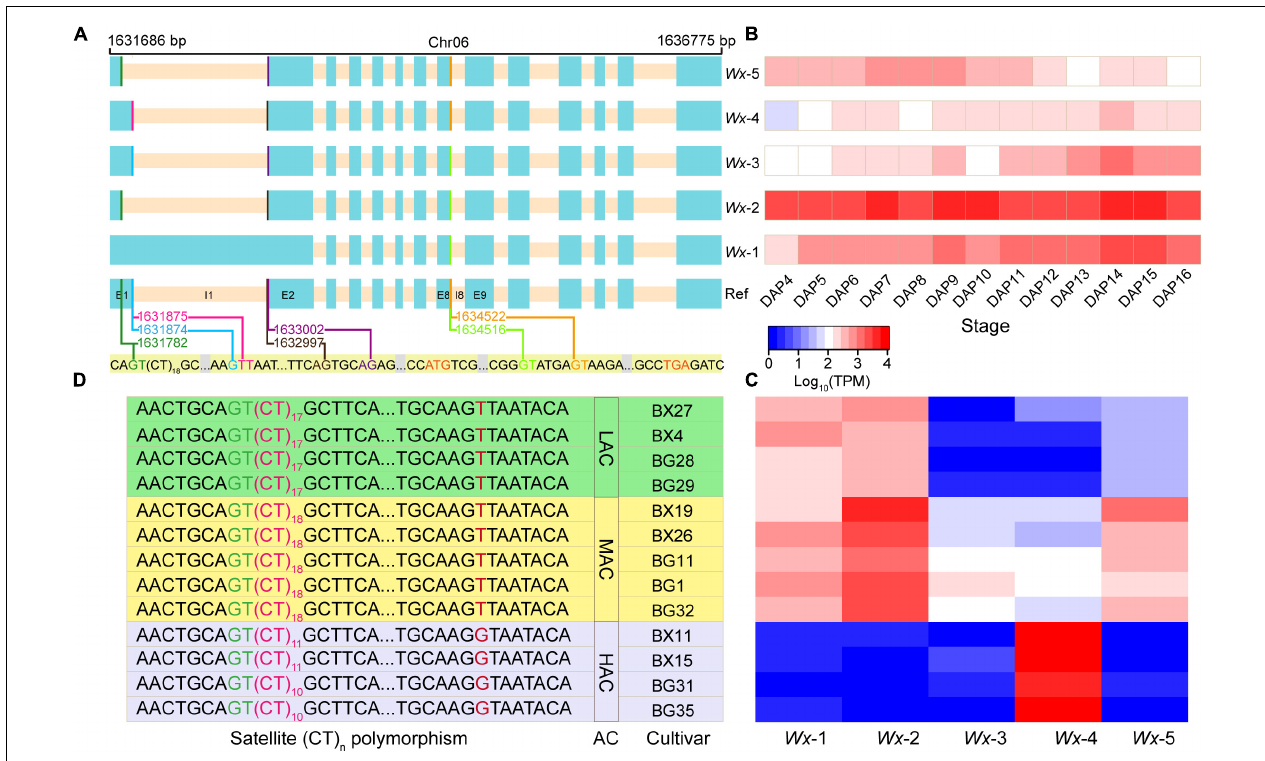
FIGURE 6 | Alternative splicing and satellite (CT) n polymorphism in the Wx. (A) Three donor splice sites (forestgreen, deepskyblue, and deeppink lines) and two acceptor splice sites (brown and darkviolet lines) in the first intron were identified. Two donor splice sites (lawngreen and orange lines) in the eighth exon were also detected, which related to the trinucleotide CAG. So, the pre-mRNA of Wx can produce five transcripts ( Wx -1, Wx -2, Wx -3, Wx -4, and Wx -5). The cyan and bisque rectangles represent the exon and intron, respectively. (B) Expression levels of the five isoforms at different stages of seed development. (C) Expression levels of the five transcripts in the rice cultivars. (D) Satellite (CT) n polymorphism in the rice population. The polymorphism is closely related to the alternative splicing in the Wx and amylose content, which indicates the potential regulation of the splicing and amylose content in the rice cultivars. BX and BG represent the inidca and japonica cultivars, respectively. AC represents amylose content, while LAC, MAC, and HAC represent low, medium, and high amylose content,